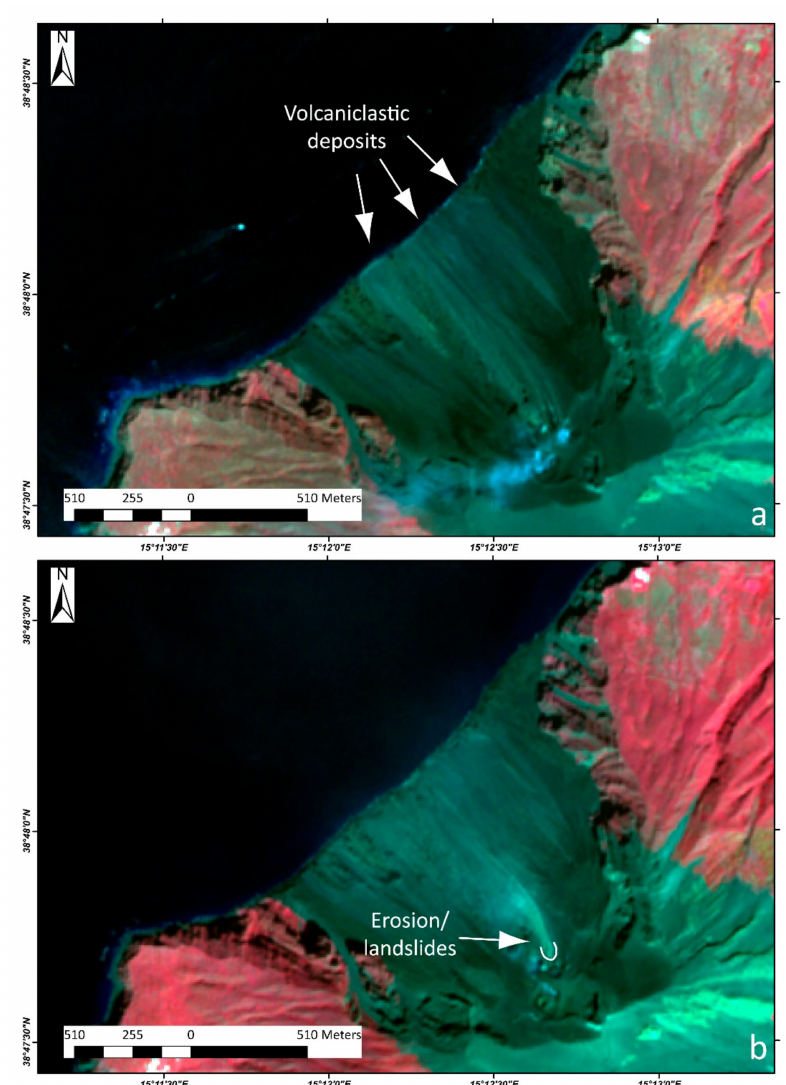
Figure 3. MSR SENTINEL-2 multi-spectral instruments (MSI) of Stromboli Island (based on bands 2, 4, and 3) collected on ( a ) 26 August 2017, showing volcaniclastic accumulation along the shoreline, and ( b ) 3 April 2018, showing the area a ff ected by erosion / landslides around the crater